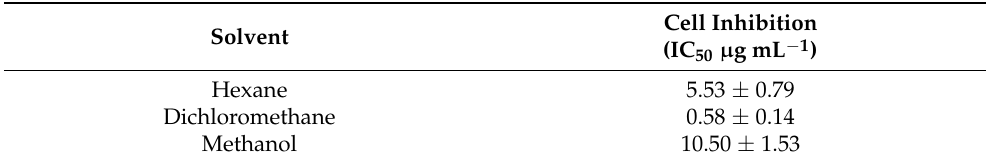
Figure 3. Antiproliferative activity of the extracts S. edule cv. Madre Negra depending on the solvent used: hexane, dichloromethane, or methanol. a: significant difference versus control (0) ( p < 0.05), b: significant difference versus positive control for the inhibition of proliferation (5 ng/mL of doxoru- bicin) ( p < 0.05) (ANOVA with a Tukey test). The bars indicate ± standard deviation. Table 1. Cell inhibition values (IC 50 ) of the S. edule cv. Madre Negra depending on the type of solvent used.